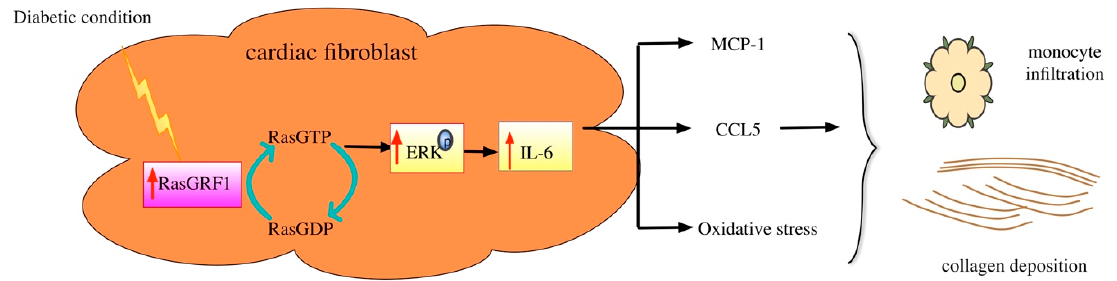
Figure 9. The possible role of RasGRF1 in diabetic cardiomyopathy.